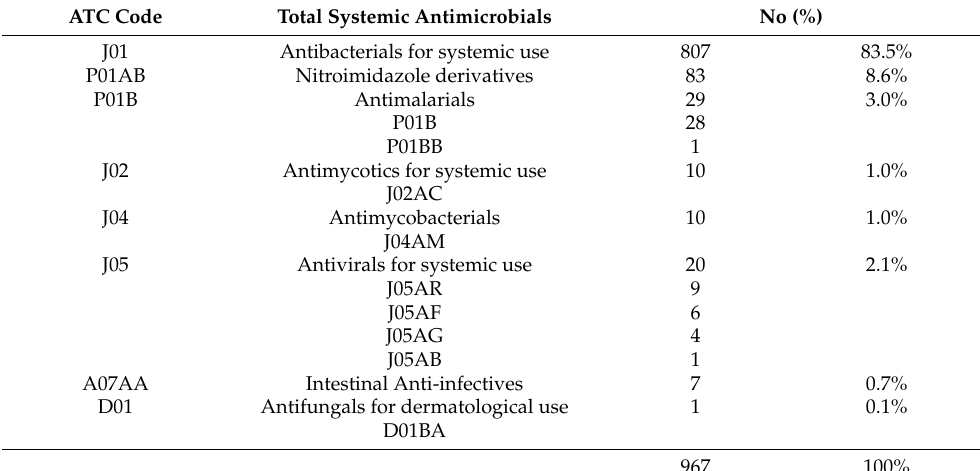
Table 5. Total systemic antimicrobials prescribed by class (WHO ATC classification,